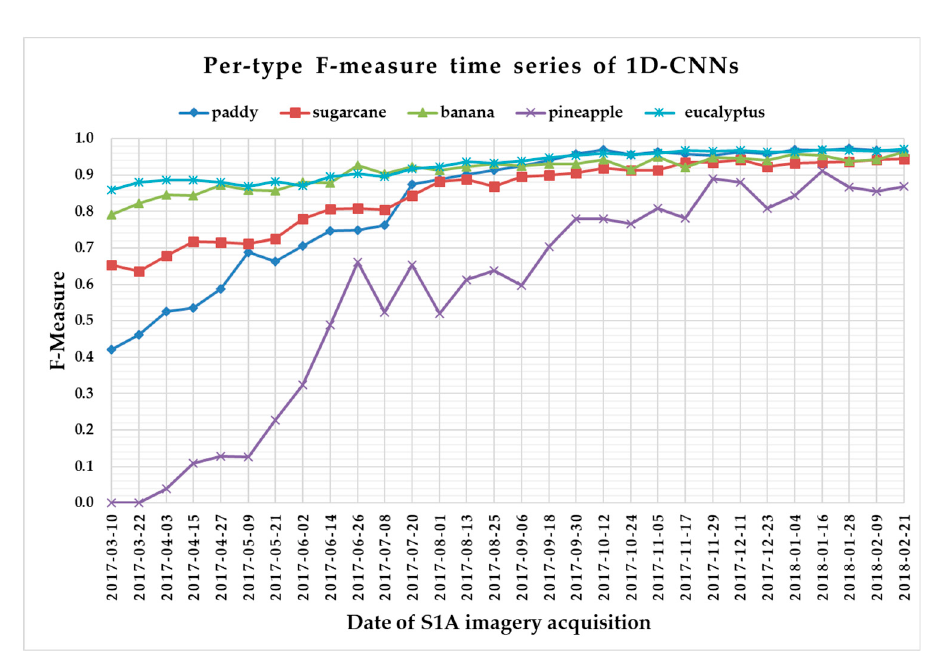
Figure 13. F-measure time series of one-dimensional convolutional neural networks.